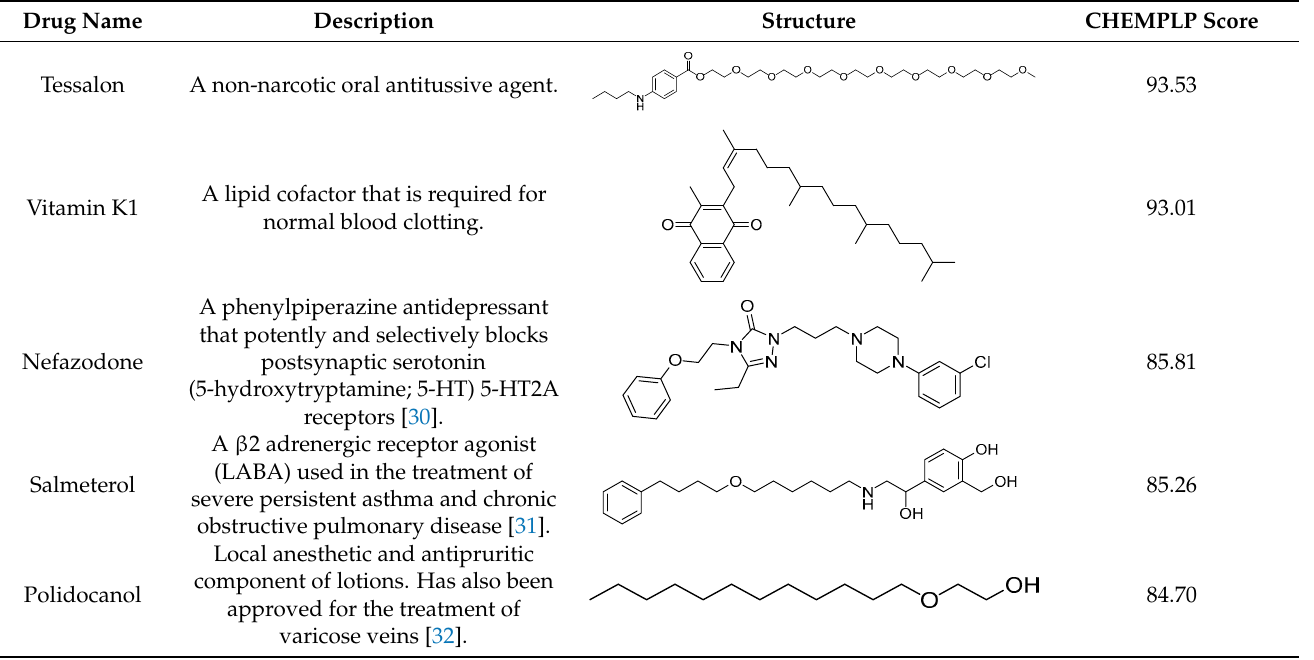
Table 4. Top 7 hits of the FDA-approved drugs database for PqsD.